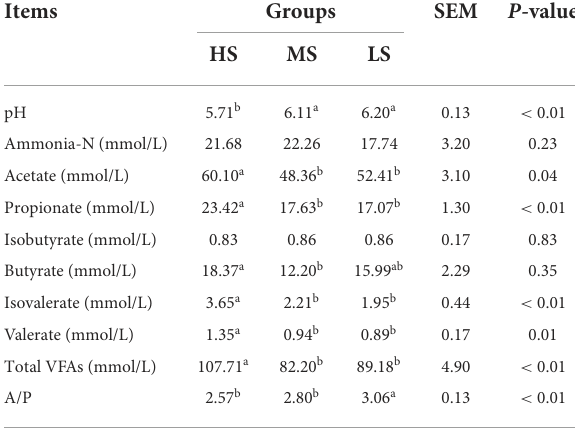
TABLE 8 Effect of different energy level diets on rumen fermentation characteristics of Tibetan